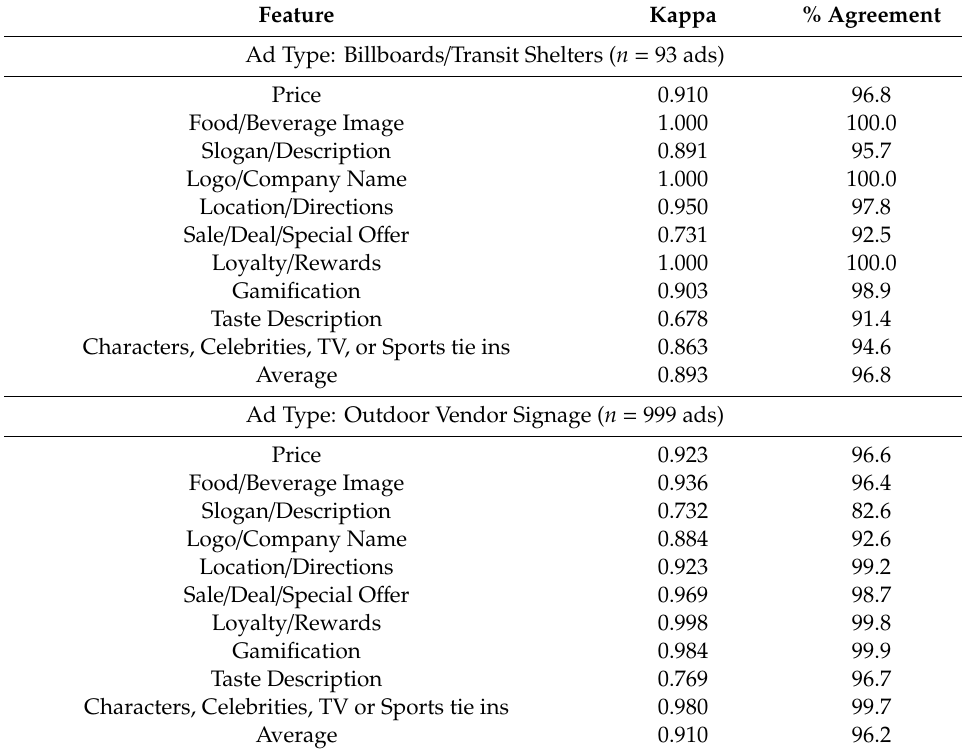
Table 4. Testing the inter-rater reliability of advertisement coding using a novel